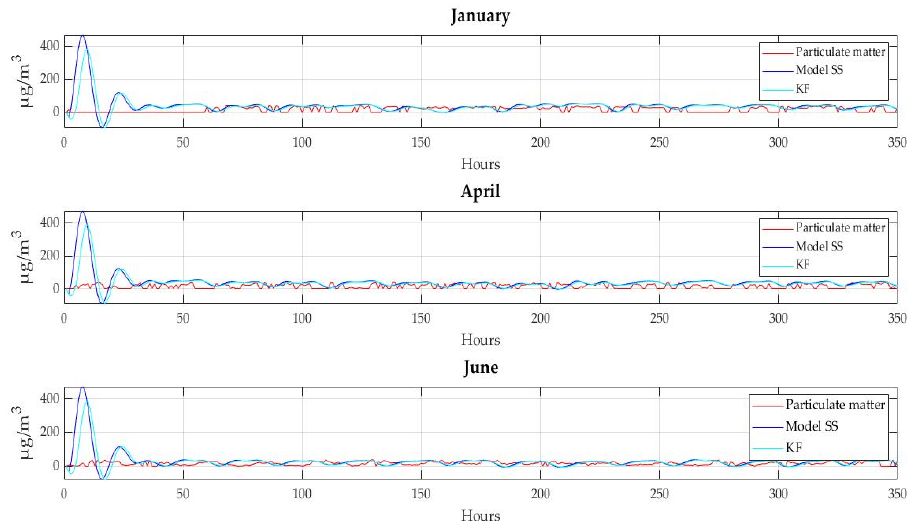
Figure 14. Validation of the model and the filter in the center of Valle de Aburrá.